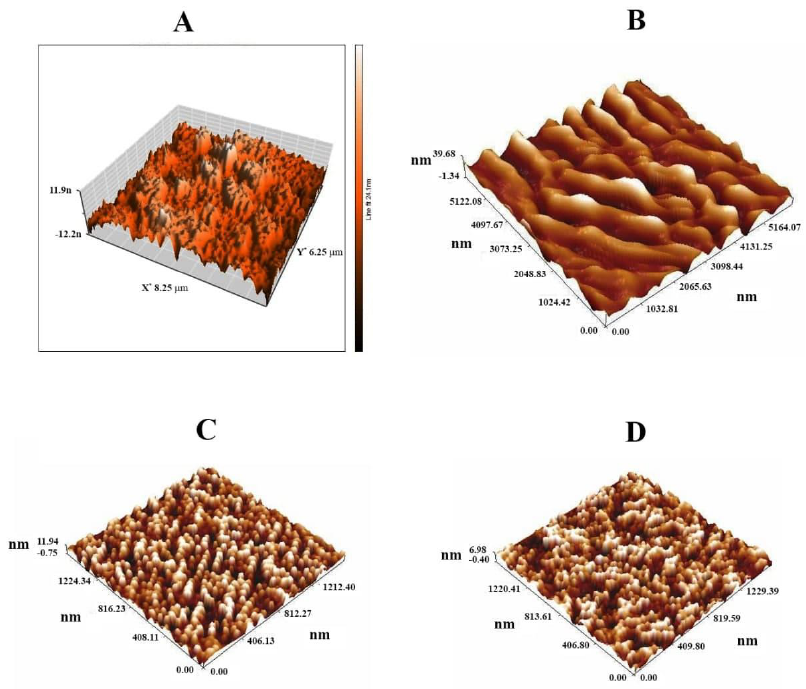
Figure 2. AFM images of ( A ): GONPs, ( B ): GONPs-PEG, ( C ): N. sativa and ( D ): GONPs-PEG- N. sativa.